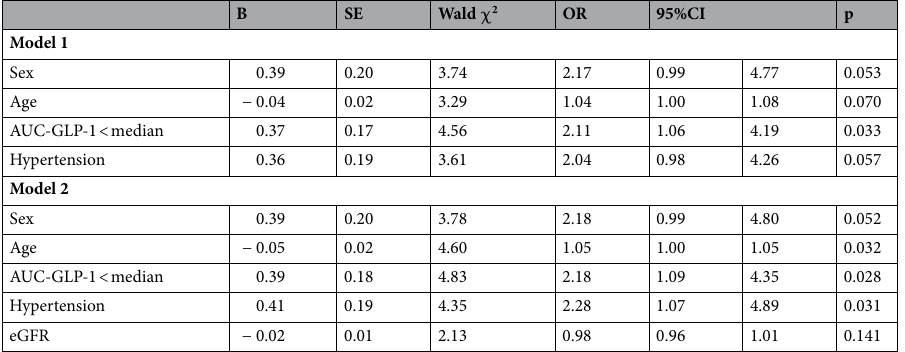
Table 5. Multivariate logistic regression analysis for GS ≥ 10. OR: odds ratio; CI: confidence interval; LDL-C: LDL cholesterol; eGFR: estimated glomerular filtration rate. Multivariate logistic analysis for Gensini score ≥ 10 was performed by using sex, age, BMI, HOMA-IR, history of hypertension, LDL-cholesterol, HDL-cholesterol, eGFR, and AUC-GLP-1 level < median as possible explanatory variables, and better fit models were selected by using Akaike Information